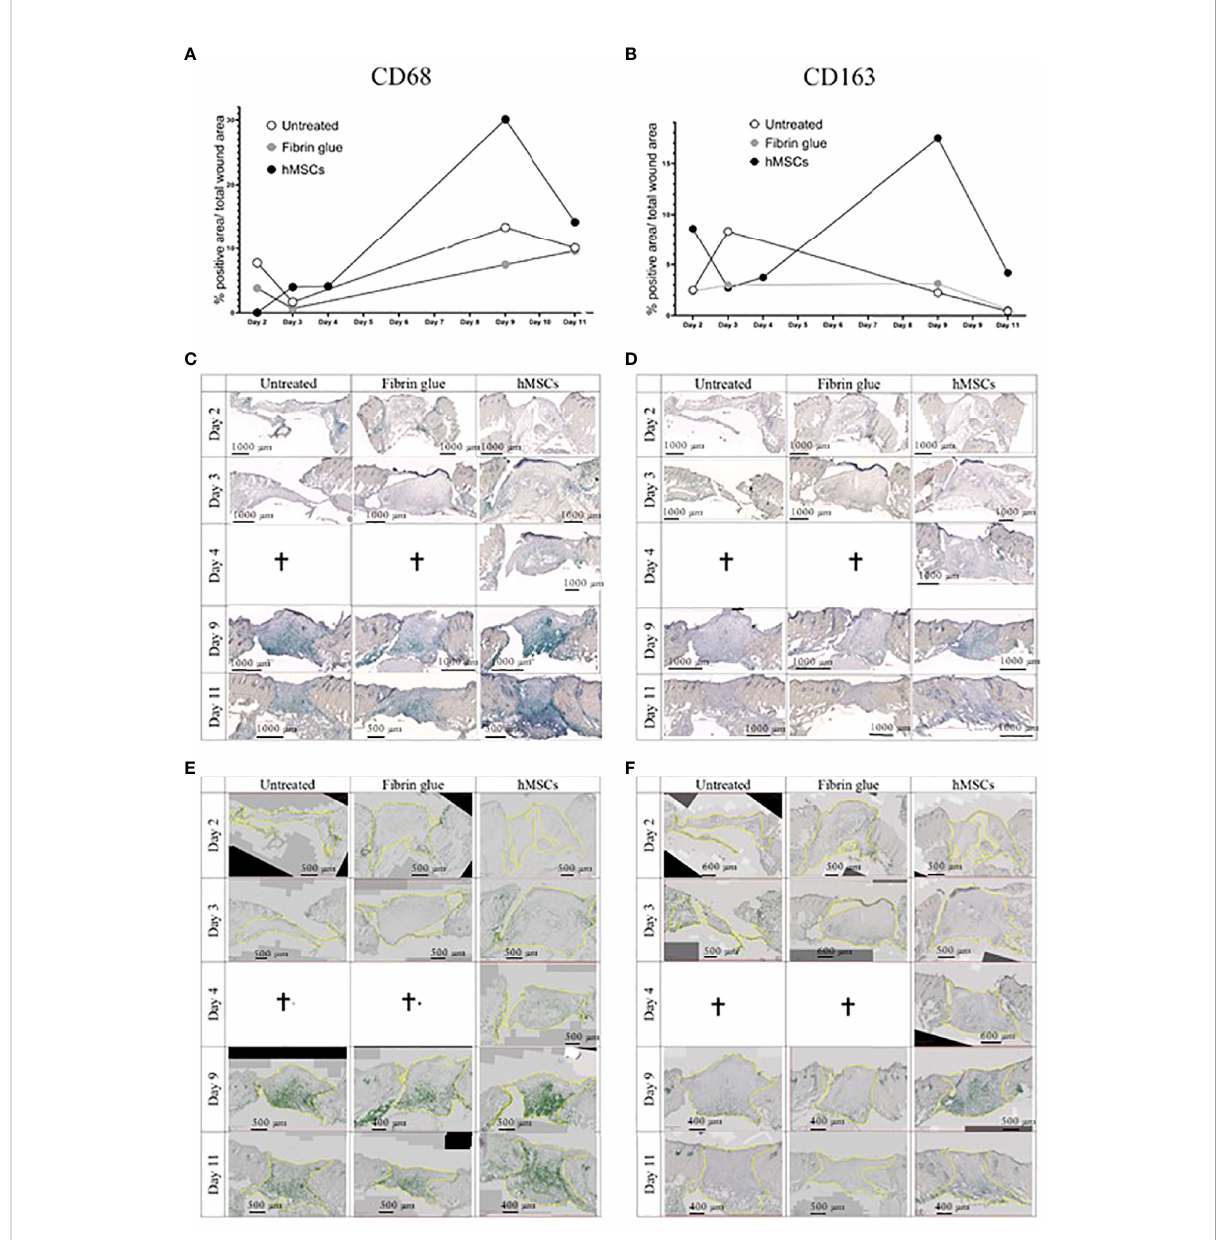
FIGURE 7 hMSCs rapidly recruit macrophages, in fi ltrating wounds from the wound edges and basis. Immunohistochemical staining of (A, C, E) CD68- and (B, D, F) CD163-positive macrophages. (A, B) Quanti fi cation as described in Figure 4. (C, D) Representative images are shown. (E, F) Wound margins are indicated in yellow, the histogreen-positive signal is highlighted and the histogreen-negative background signal reduced to visualize macrophage recruitment kinetics and